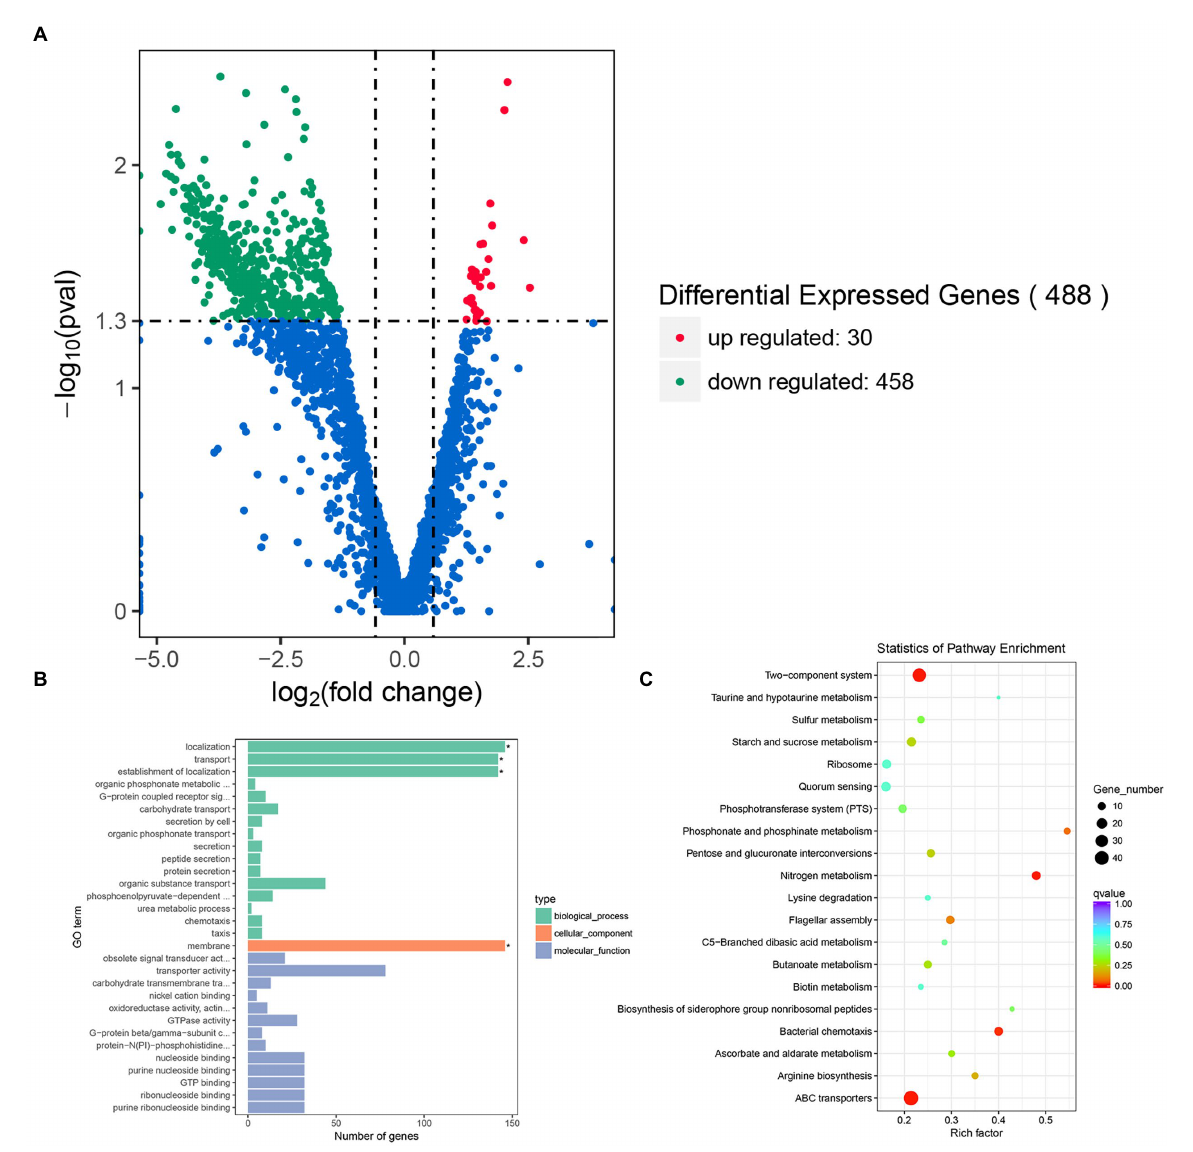
FIGURE 2 Transcriptomic analysis of E. cloacae between rpoS -RNAi and wild-type strains. (A) The volcano plot of DEGs, the red dots were up-regulated genes and the green dots were down-regulated genes. (B) GO analysis of differential expression genes of rpoS -RNAi and wild-type strains. (C) The Top20 KEGG enrichment pathways for DEGs, the rich factor refers to the ratio of the number of DEGs in the pathway and the number of all annotated genes in the